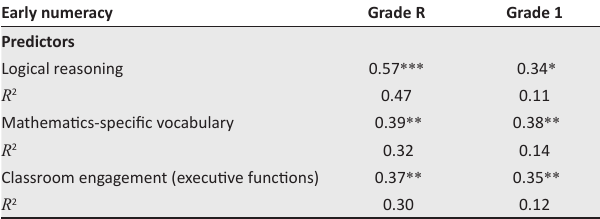
TABLE 3: Standardised regression coefficients depicting associations between cognitive skills and number concept development for Grade R and Grade 1. Early